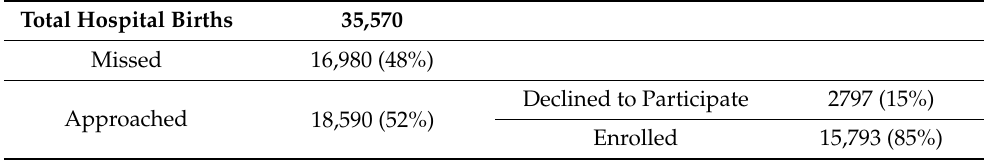
Table 1. Year one enrollment summary (October 2019 to September 2020).